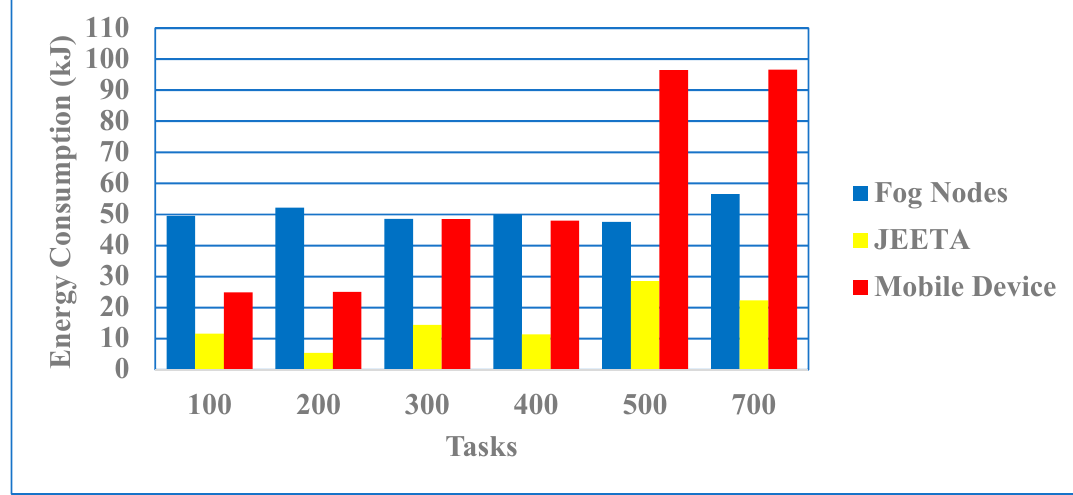
Figure 3. Energy consumption of entire mob-cloud.